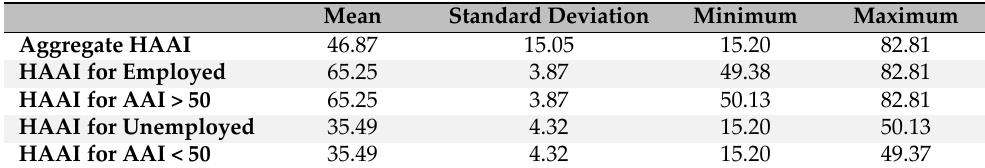
Table 3. The Levels of Healthy and Active Ageing Index.